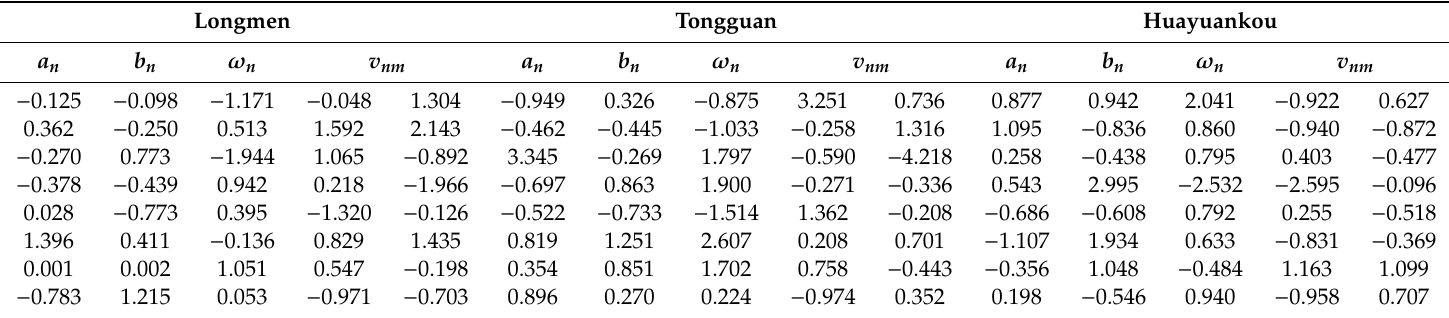
Table 10. Related parameters of SL − SSC cointegration equation.